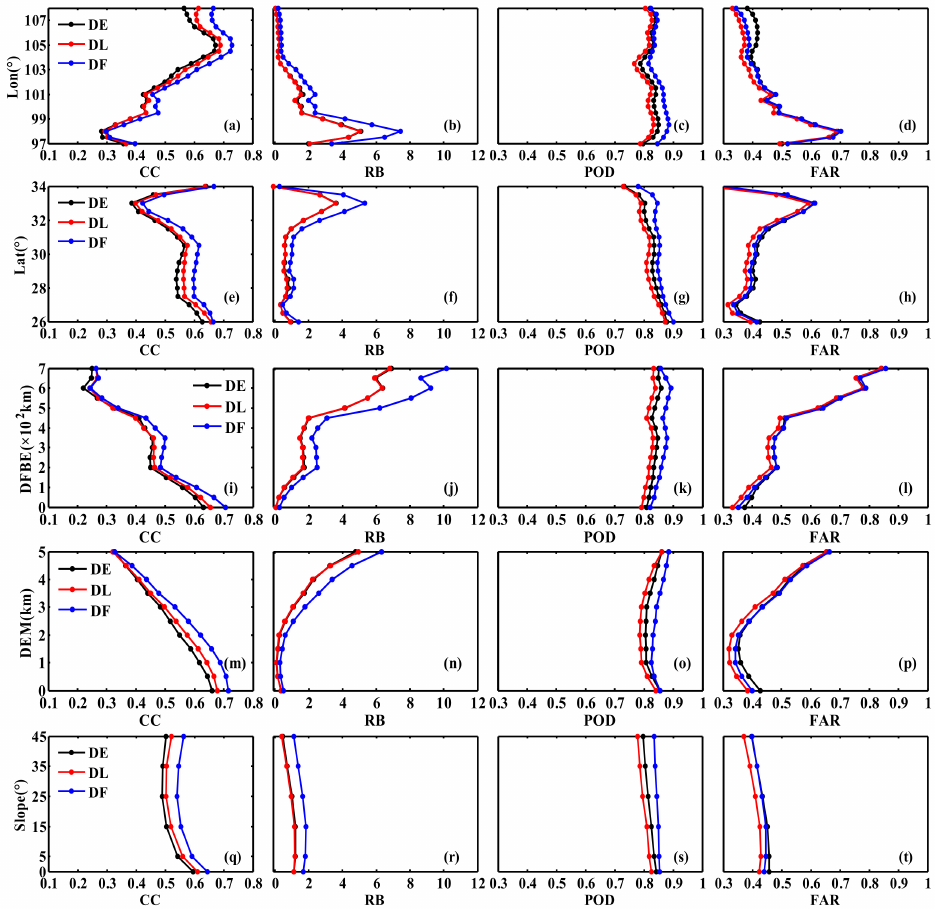
Figure 4. The distributions of statistical metrics with different geographical features for the IMERG- DE, DL, and DF estimates. From left to right, four columns represent the CC ( a , e , i , m , q ), RB ( b , f , j , n , r ), POD ( c , g , k , o , s ), and FAR ( d , h , l , p , t ). From top to bottom, the five rows represent longitude ( a – d ), latitude ( e – h ), DFBE ( i – l ), DEM ( m – p ), and slope ( q – t ),